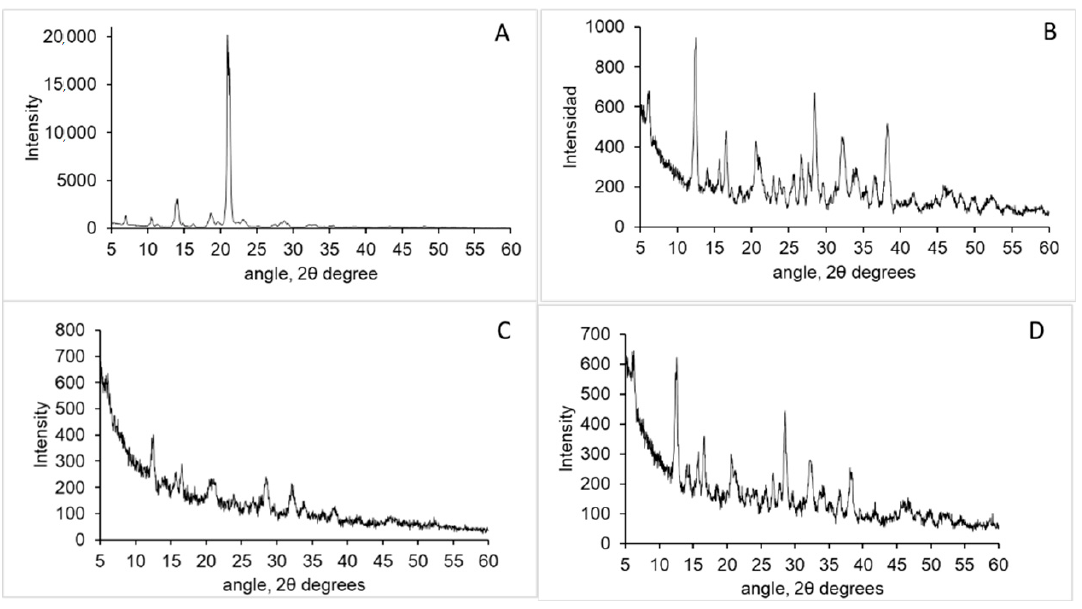
Figure 5. XRD patterns of Risperidone ( A ), glycerolphosphate ( B ), xerogel from cuttlebone chitosan ( C ) and xerogel from squid pen chitosan ( D ).